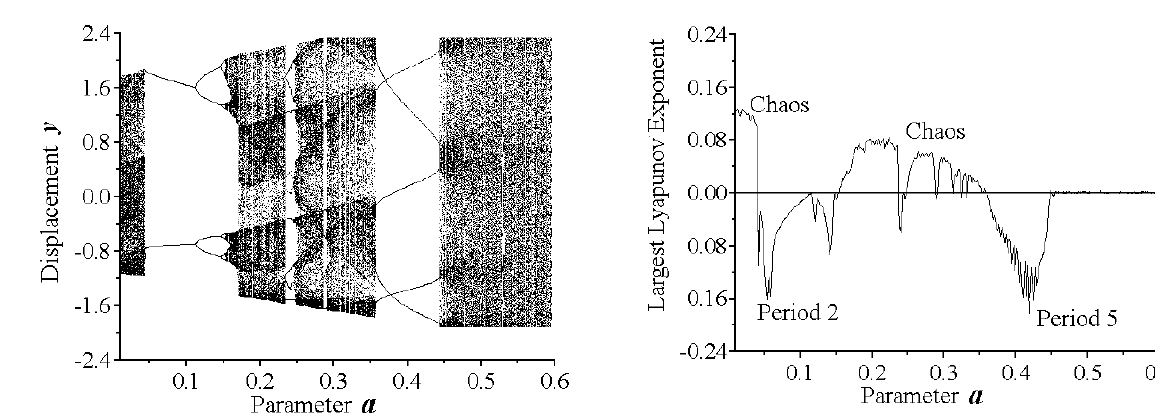
Fig. 6. Bifurcation diagram of the nonlinear system with a time-varying clearance.